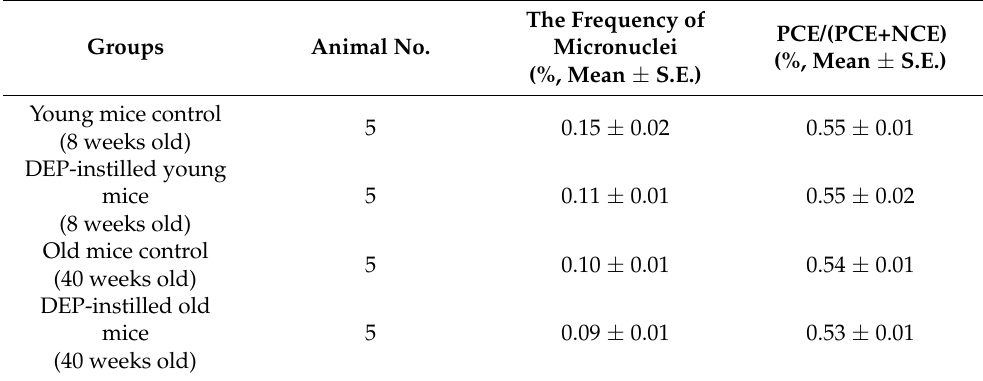
Table 3. The frequency of micronuclei and PCE/(PCE+NCE) ratio in the bone marrow of female mice. Groups Animal No.